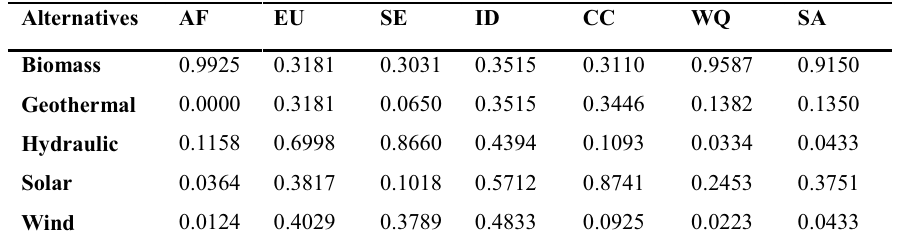
Table 6: Normalized decision matrix (R):